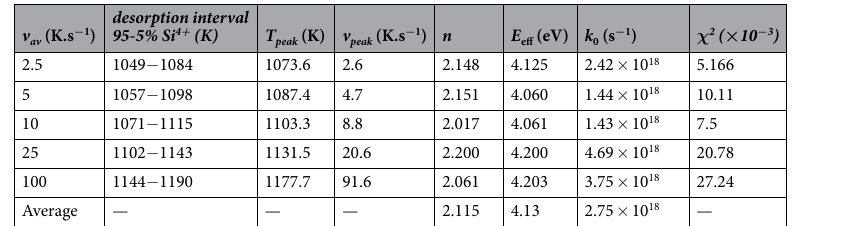
— — — Table 1. The desorption temperature interval is comprised between 95% and 5% of the Si 4 + component intensity (Fig. 6). The temperature of maximum desorption rate (T peak ) corresponds to a fractional coverage 38 . v equal to = . 0 368 1 is the heating velocity at T peak . Avrami exponent (n), coefficient (k 0 ) and effective peak e activation energy (E eff ) are deduced from the fits of Fig. 6. The fitting method is described in “Methods”, subsection “Fitting of the desorption curves with a non-isothermal Avrami Kinetic Model”. The Chi-square value ( χ 2 ) is also